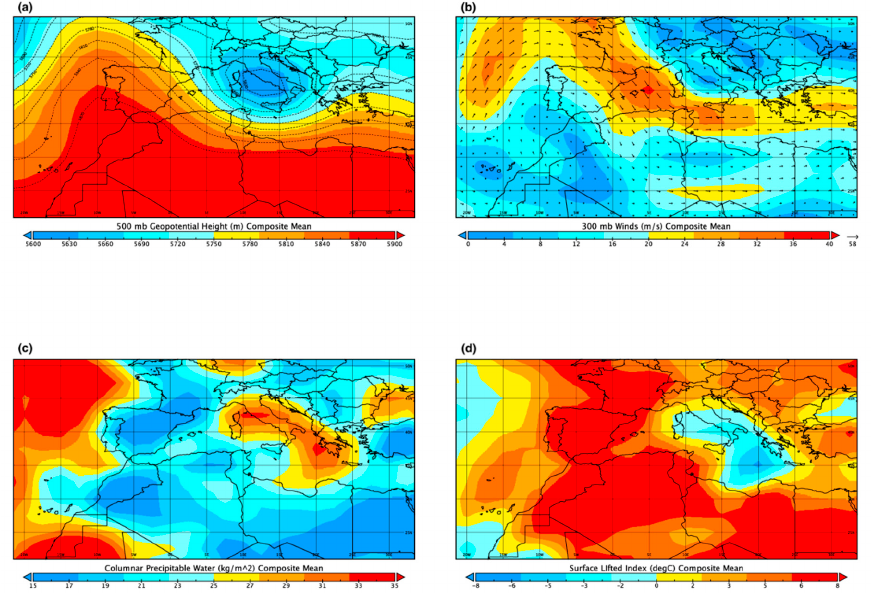
Figure 1. 6-Hourly NCEP/NCAR Reanalysis Data Composites at 0600 UTC of 26 September 2006 of geopotential height at 500 mb ( a ); wind field at 300 mb ( b ); Columnar precipitable water ( c ); surface lifted index ( d ).